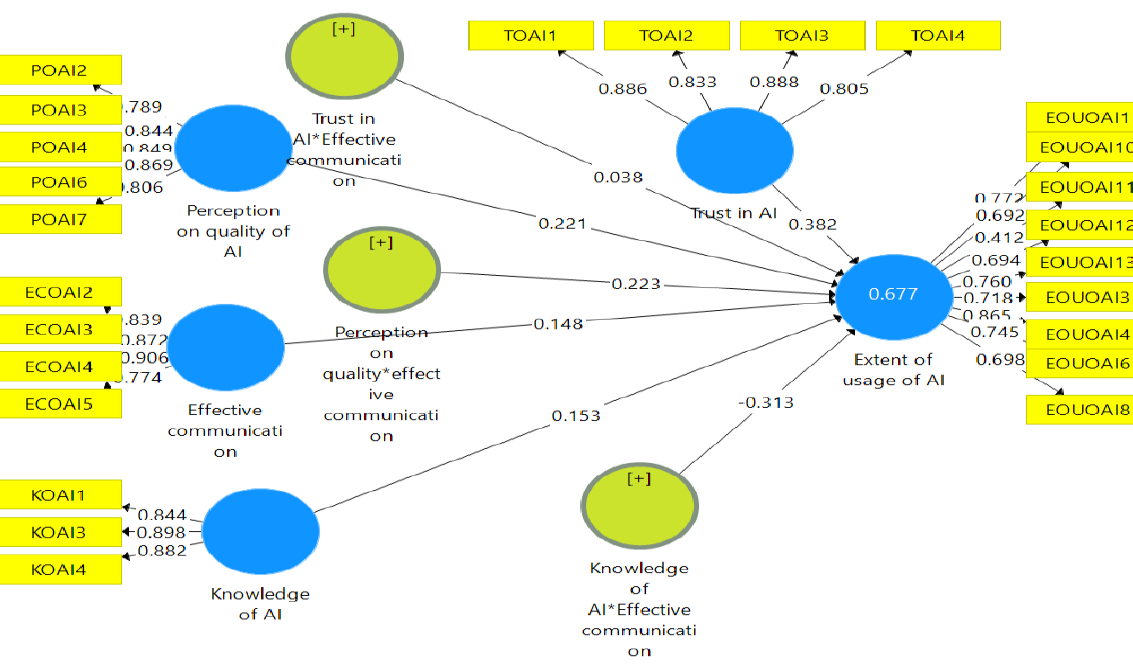
Figure 3: Moderation